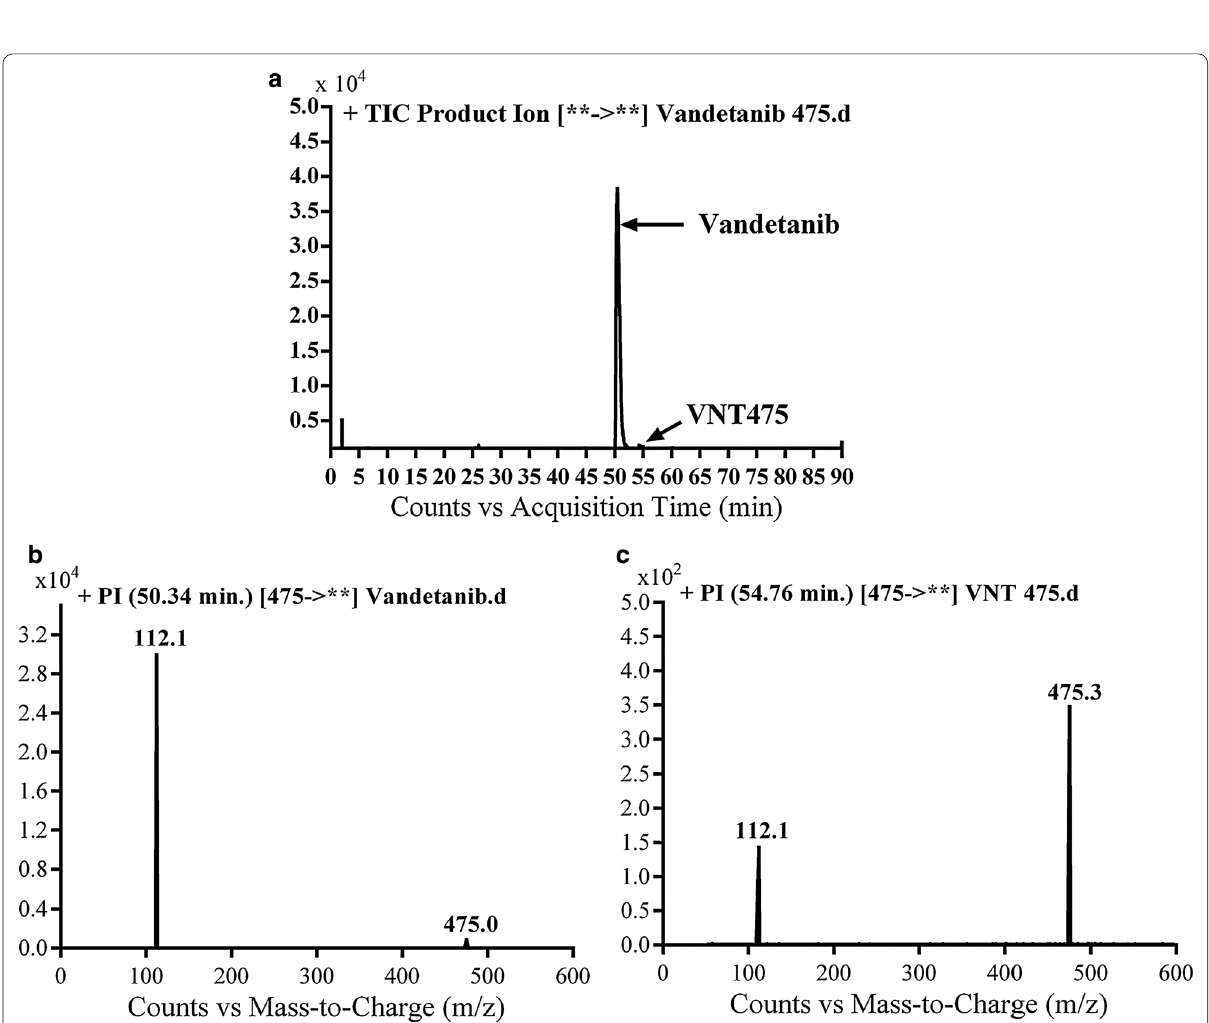
Fig. 1 EIC of MIP at m/z 475 showing two peaks; vandetanib (50.3 min) and VA475 (54.8 min) ( a ), PI mass spectrum of vandetanib ( b ) and PI mass spectrum of VA475 at m/z 475 ( c )